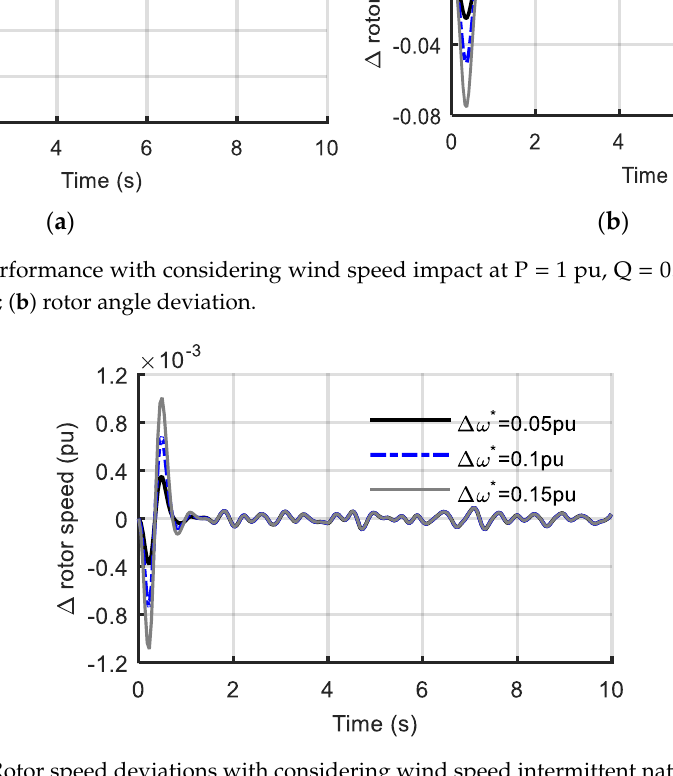
Figure 10. DFIG performance due to 0.05 pu step load demand at P = 1.0 pu, Q = 0.25 pu. ( a ) DFIG rotor speed deviation; ( b ) DFIG power output deviation.